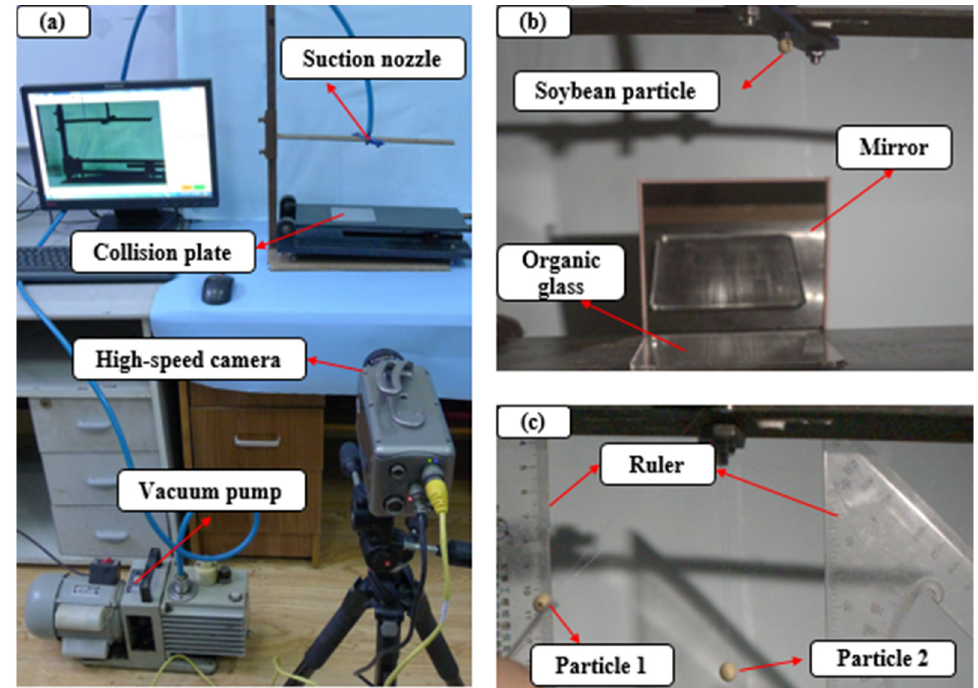
Figure 13. ( a ) Device for the measurement of the coefficient of restitution and the photos for meas- uring: ( b ) The coefficient of restitution between the particle and the boundary and ( c ) the coefficient of restitution between two particles.